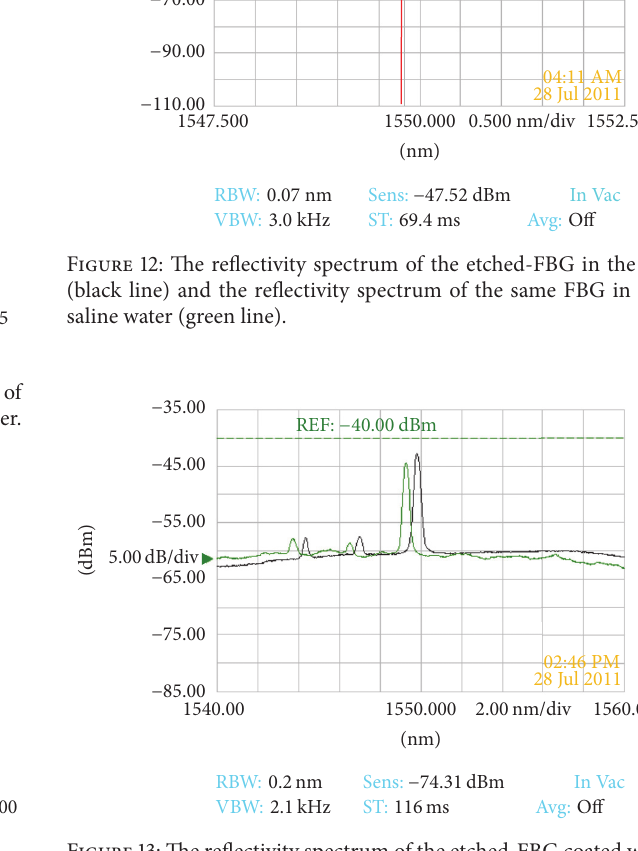
Figure 13: The reflectivity spectrum of the etched-FBG coated with TiO 2 NMO in the air (black line) and the reflectivity spectrum of the same FBG in the deionized water (green line).